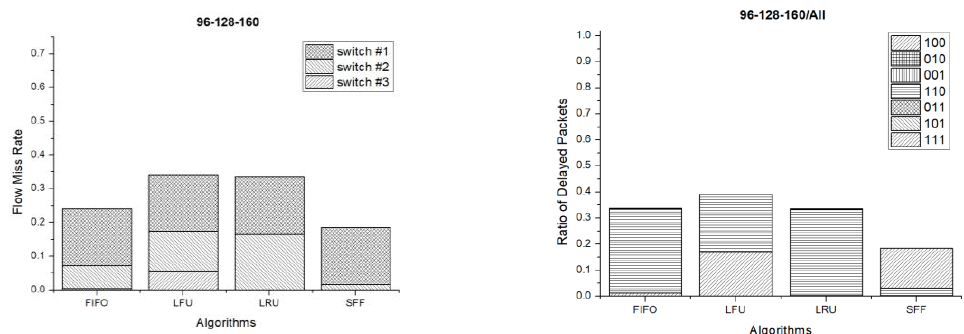
Figure 13. Experiment results with 96-128-160 flow table size.